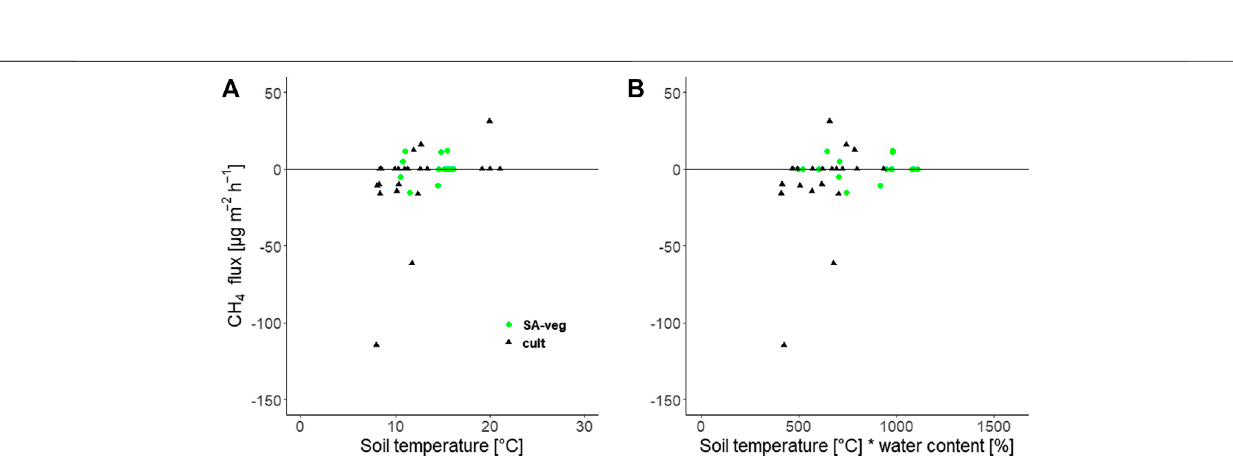
FIGURE 4 | Methane (CH 4 ) fl ux [µg m − 2 h − 1 ] as a function of (A) soil temperature at 5 cm depth and (B) the interaction between soil temperature and volumetric water content, at the set-aside site (SA-veg ( ○ )) and the cultivated site ( ▲ ). No signi fi cant relationship was found.